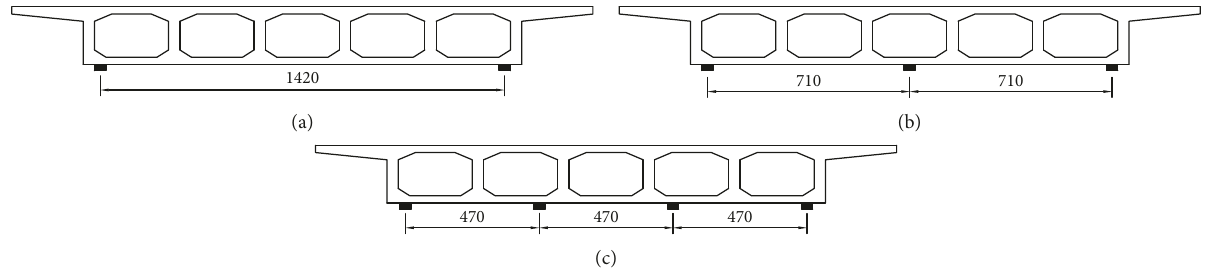
Figure 4: Layout of the bearings in different models (unit: cm). (a) Model SPT-2. (b) Model SPT-3. (c) Model